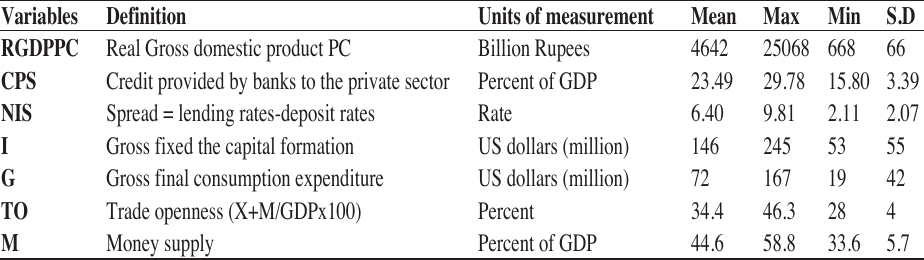
Table 2: Descriptive Statistics of the